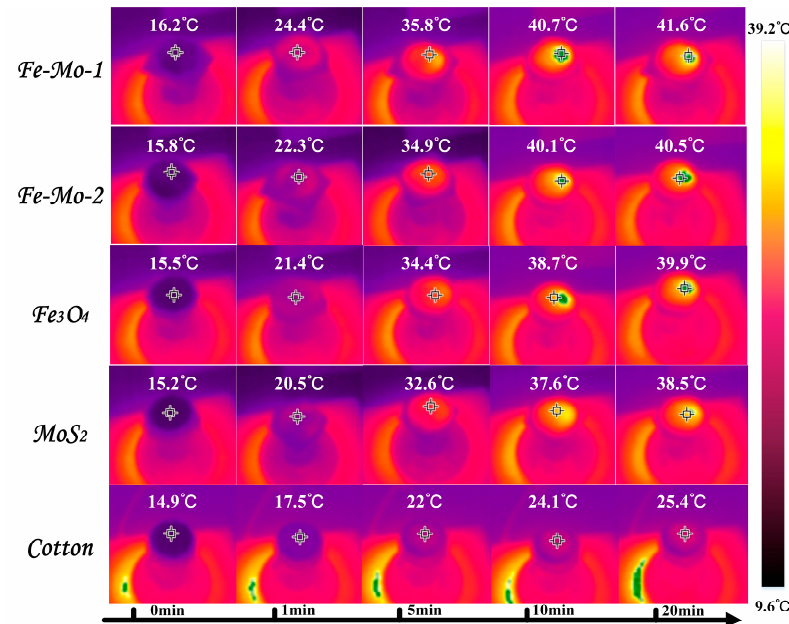
Figure 4. Infrared radiation images of different samples at different times in the test process.